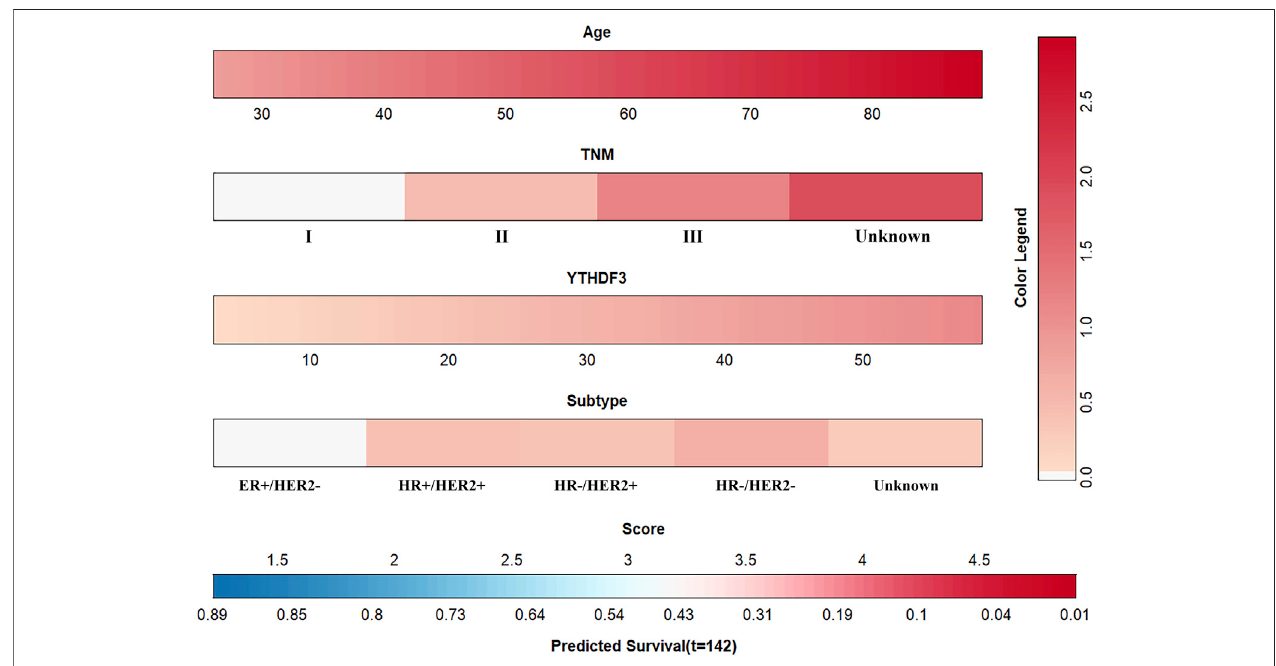
FIGURE 5 | Prognostic model for predicting 5-year OS in BC